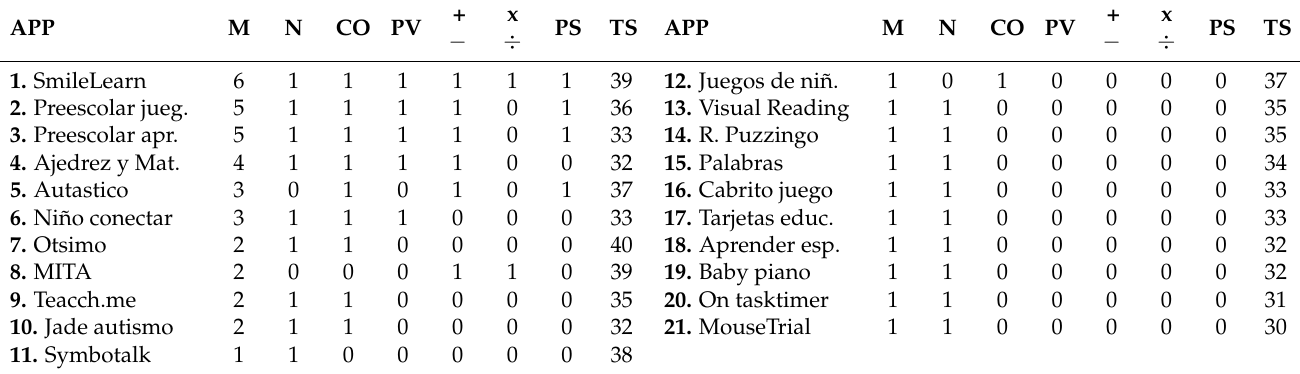
Table 8. Apps focused on mathematics ordered according to the score obtained in this skill and the sub-areas it comprises.